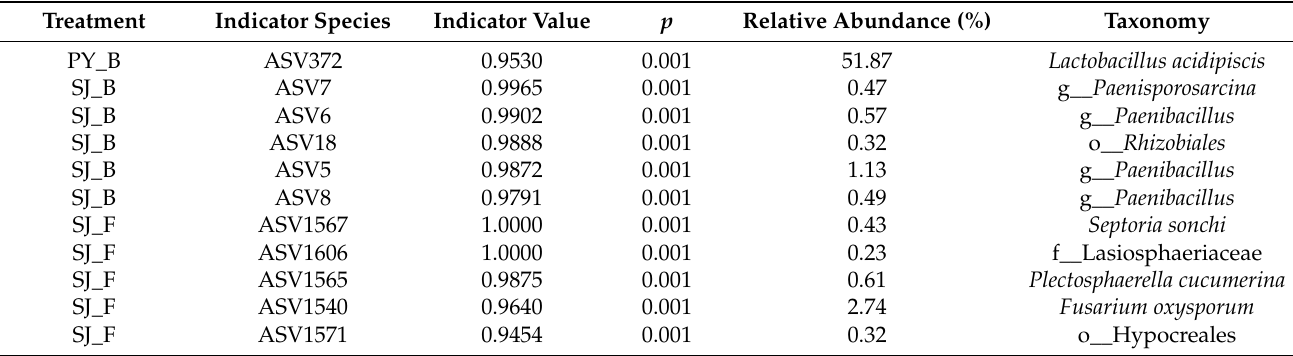
Table 3. Intestinal bacterial and fungal indicator species of Hooded Crane of the lake groups between Poyang and Shengjin Lakes. The top five indicator taxa according to the indicated value were listed (except for indicator value < 0.6). o: order; f: family; g: genus. PY: Poyang Lake; SJ: Shengjin Lake; B: bacteria; F: fungus.